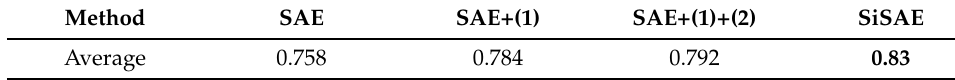
Table 3. Ablation Experiments with the SiSAE